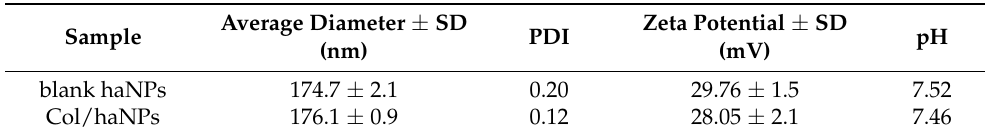
Table 1. Physico-chemical parameters of blank and Col loaded